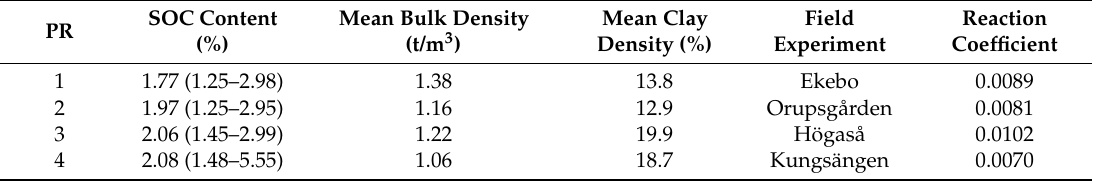
Table A20. Data for the parameterization and long-term field experiments used for calibration of the ICB model [79] for SOC simulations used in the SOC balance estimations